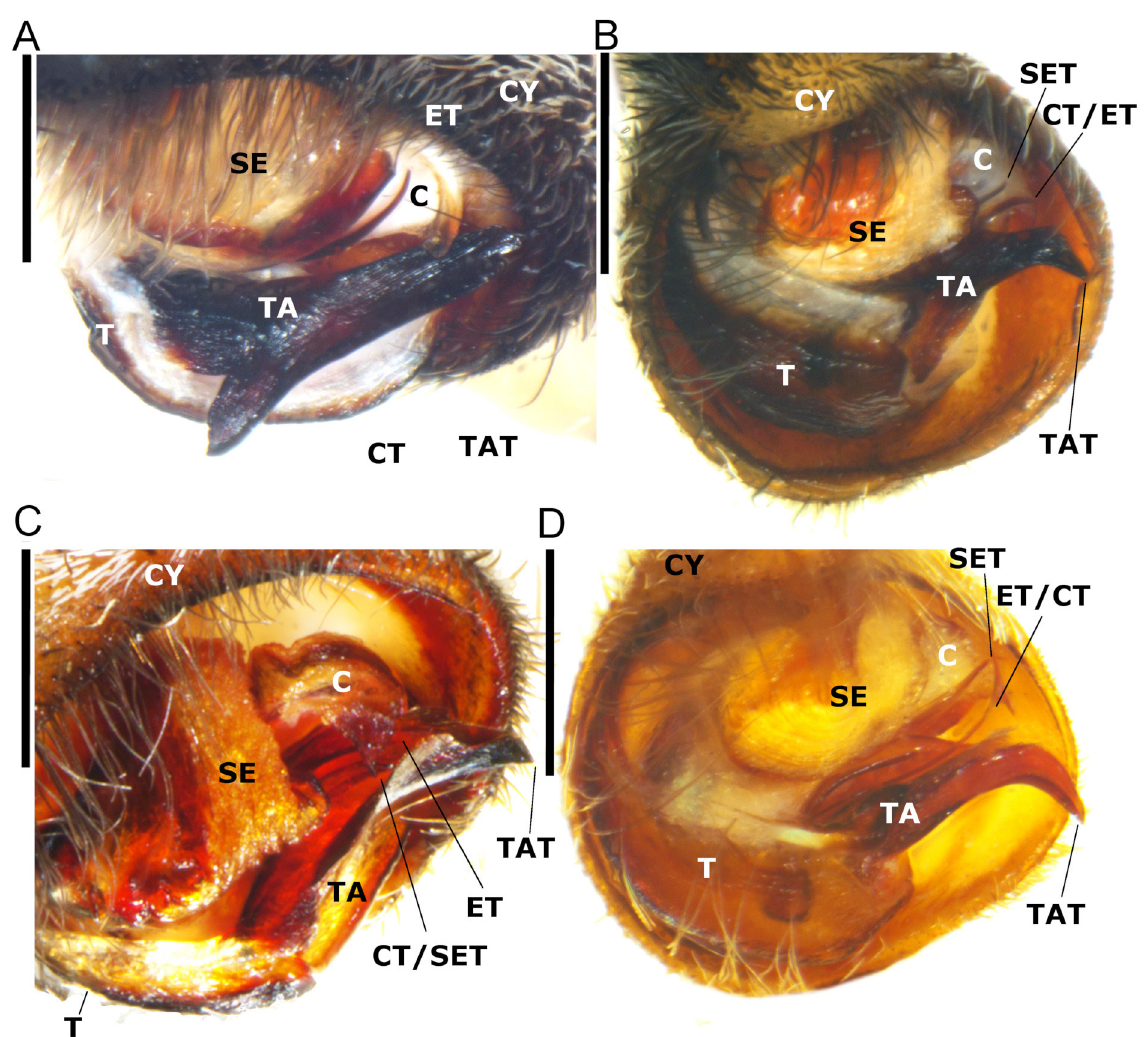
Fig. 5. Male pedipalps, distal view. A . Geolycosa vultuosa C.L. Koch, 1838 (HUJ INV-AR20960). B . Lycosa gesserit sp. nov . , holotype (HUJ INV-AR20631). C . Lycosa hyraculus sp. nov., holotype (HUJ INV-AR20818). D . Lycosa piochardi Simon, 1876 (HUJ INV-AR20948). Scale bars = 0.5 mm. Photos by I. Armiach